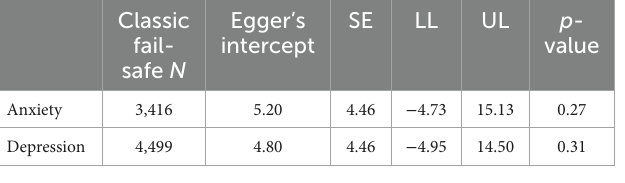
TABLE 2 Publication bias of analysis.